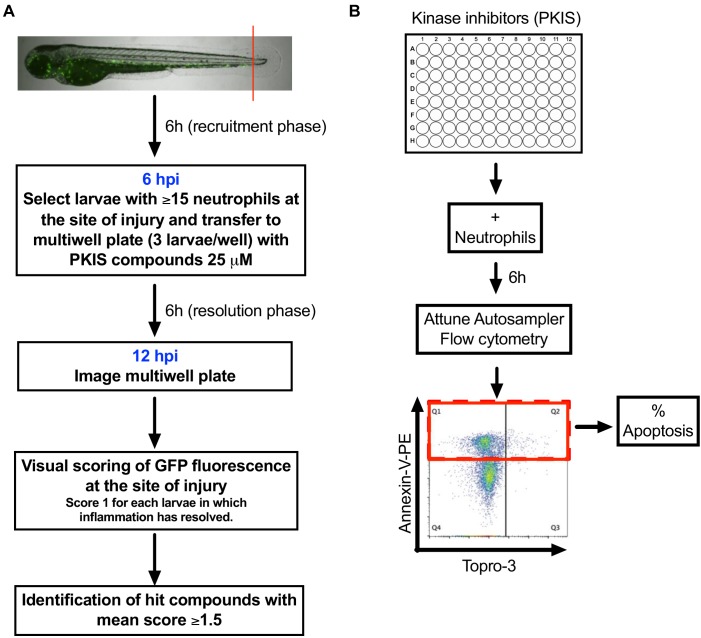
Schematics showing PKIS screen design.(A) Tail fin transected three dpf Tg(mpx:GFP)i114 zebrafish larvae that had generated an inflammatory response at six hpi were incubated with individual PKIS compounds [25 µM] for a further 6 hr. Larvae were imaged and manually scored between 0–3 on the basis of green fluorescence at the injury site. (B) PKIS compounds were incubated with primary human neutrophils for 6 hr. Apoptosis was assessed by Annexin V/TO-PRO-3 staining by flow cytometry and the percentage apoptosis calculated as Annexin V single plus Annexin V/TO-PRO-3 dual positive events (as indicated by red box).